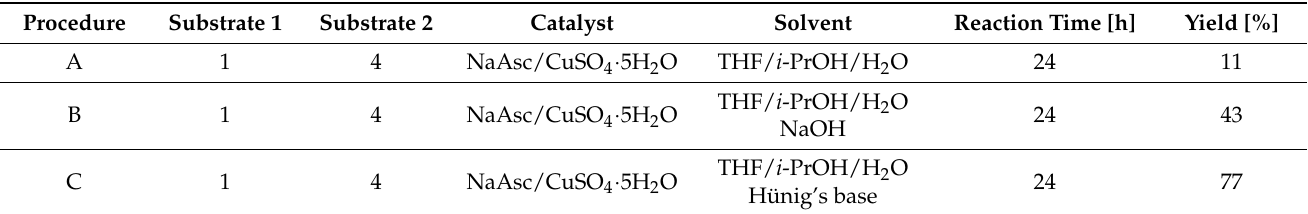
Table 2. Adjusting the CuAAC reaction conditions (copper catalyzed azido-alkyne cycloaddition).